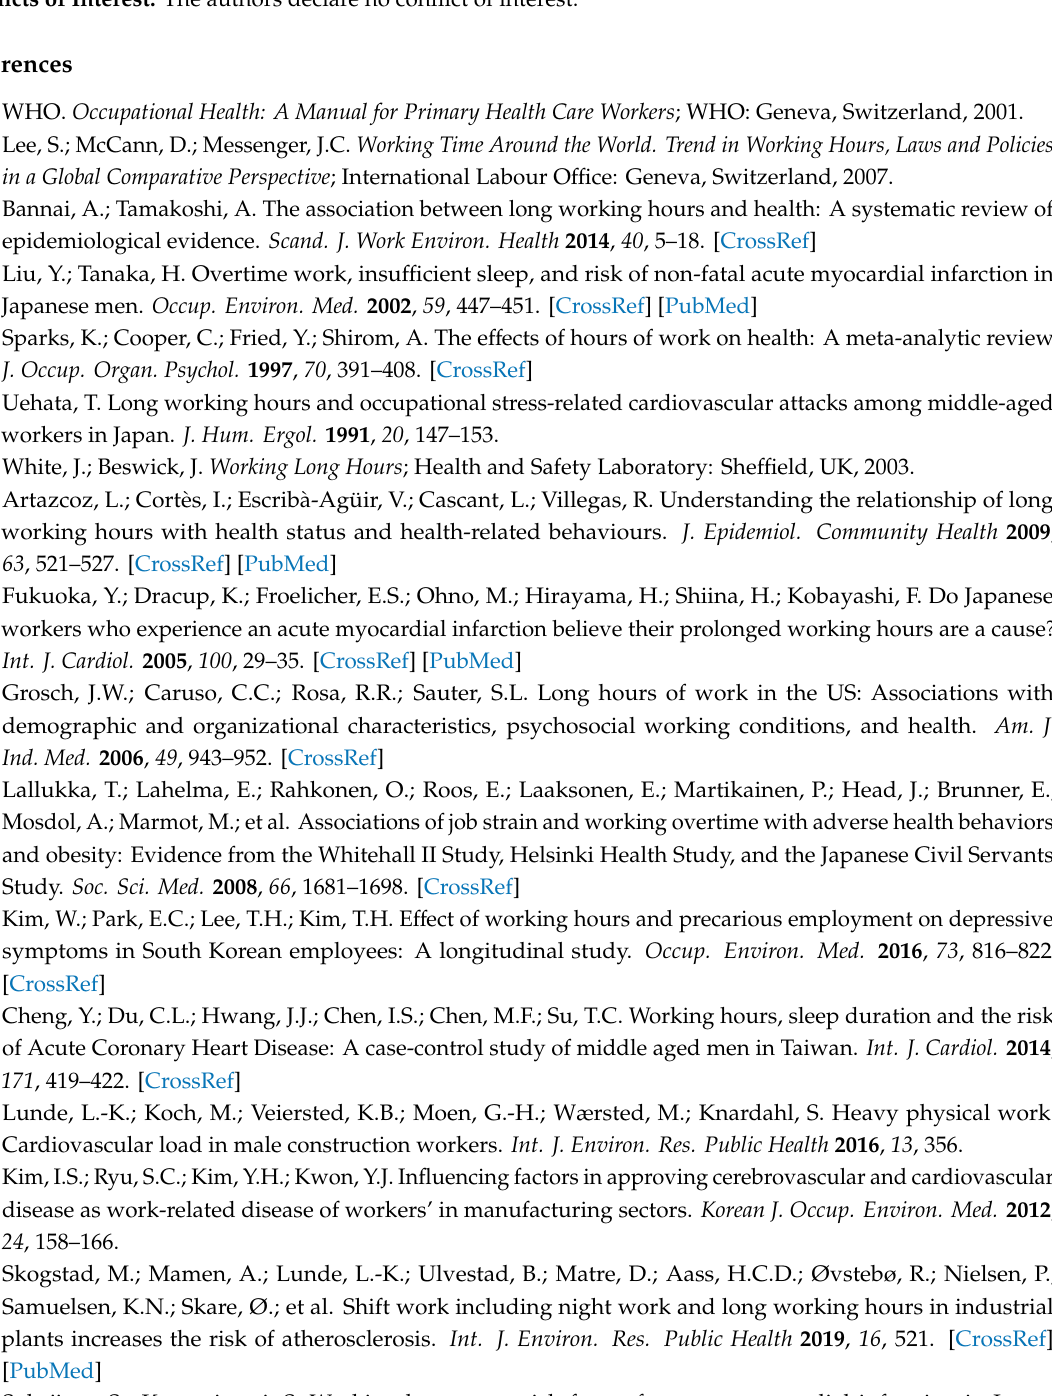
Table S1: The information and odds ratios of the 46 papers (sorted in year of